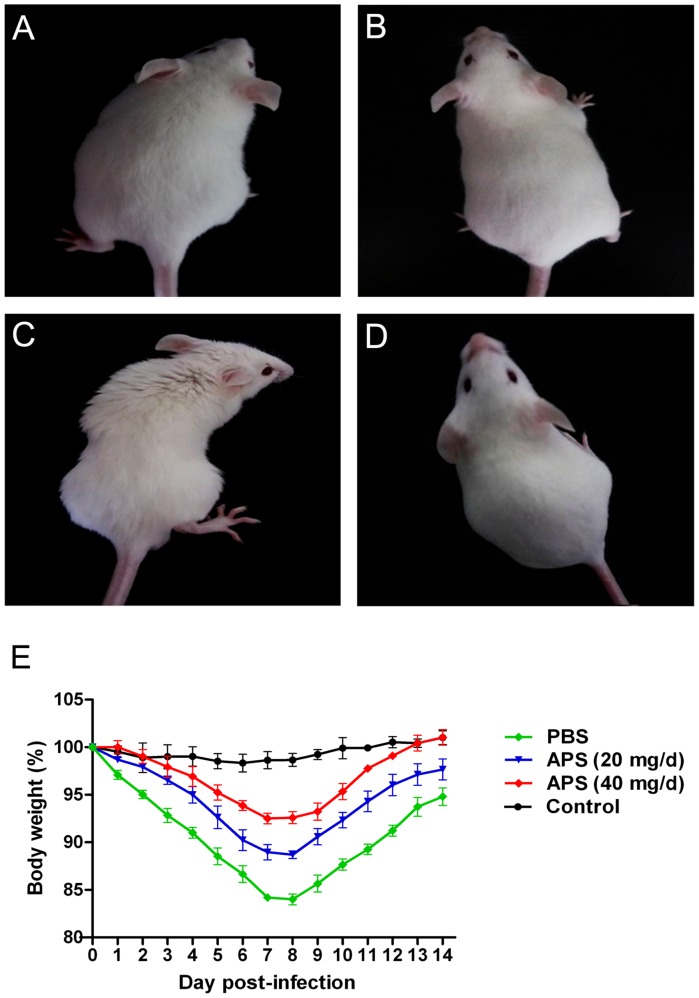
Aloe polysaccharides reduces the clinical symptoms of infected mice. All 60 mice in groups I (A), II (B), and III (C) were infected intranasally with the 105 TCID50 of virus. Then the mice in groups I and II were orally administrated with 20 and 40 mg of APS per day, respectively, and group III were orally administrated isometric PBS. Another 20 virus-free mice in groups IV (D) served as the normal control. The typical clinical symptoms were recorded at 7 dpi (A–D), and the body weight loss (E) of animals were recorded every day up to 14 dpi.